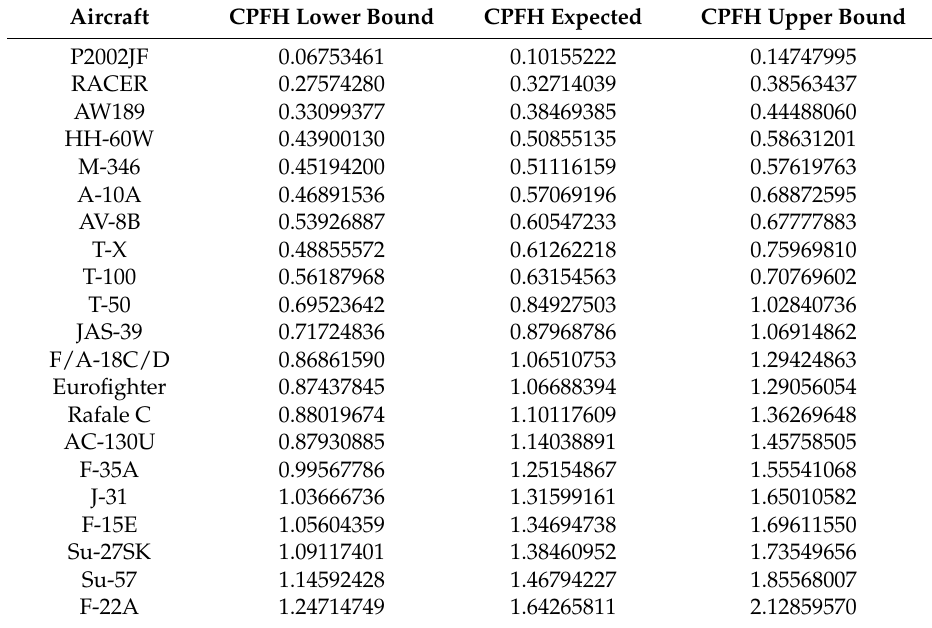
Table 7. A comparative application of mean CPFH predictions with 95% CI for a set of ‘unknown’ aircraft types. The figures indicate ‘times the mean CPFH of F-16 Block